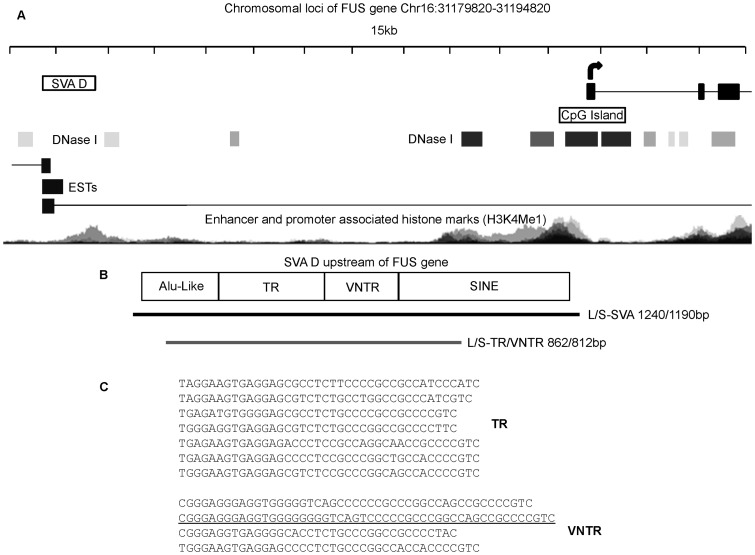
Loci of FUS gene and structure of SVA D located upstream.A- Schematic of loci of the FUS gene located on chromosome 16. According to UCSC genome browser (Hg18) there are several transcripts with nearly all originating at the transcriptional start site indicated in the diagram. There is a SVA D 9.9kb upstream of this transcriptional start site of the FUS gene. This SVA D is present in human and chimpanzees but not other primates. ENCODE data from the genome browser UCSC is summarised indicating the presence of DNase1 clusters, expressed sequence tags (ESTs) and histone modifications associated with enhancers and promoter at this locus. B- Schematic showing the components contributing to the structure of the SVA D located upstream of the FUS gene. It contains an Alu-like sequence, a tandem repeat (TR) consisting of 7 copies of a 37–40 bp repeat, a variable number tandem repeat (VNTR) consisting of 3–4 copies of a 37–50 bp repeat and a SINE. This particular SVA is missing the CCCTCT hexamer repeat seen at the 5′ end of a canonical SVA. The fragments cloned into the reporter gene vector (pGL3P) are shown by the black line for the SVA (length 1240/1190 bp) and the grey line for the TR/VNTR (length 862/812 bp). C- Sequence of the 7 copies of the 5′ TR and 3–4 copies of the 3′ VNTR. The repeat underlined is the additional copy found in the long allele which is absent in the short allele of the SVA (sequence in UCSC genome browser corresponds to long allele).